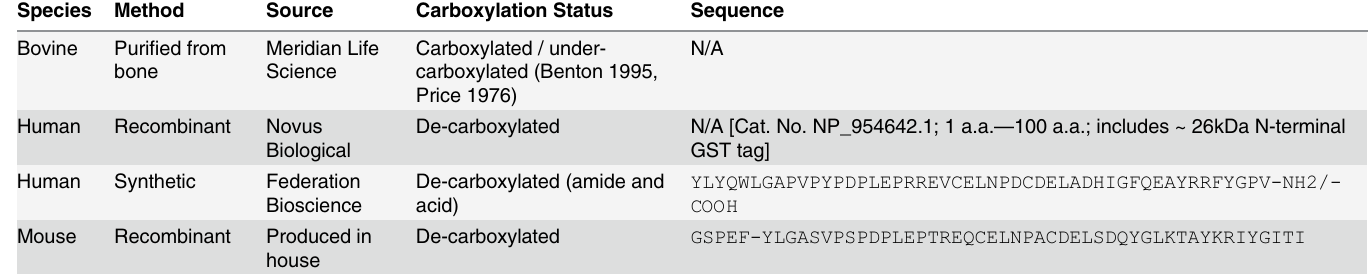
Table 1. Osteocalcin (OCN) variants used in this